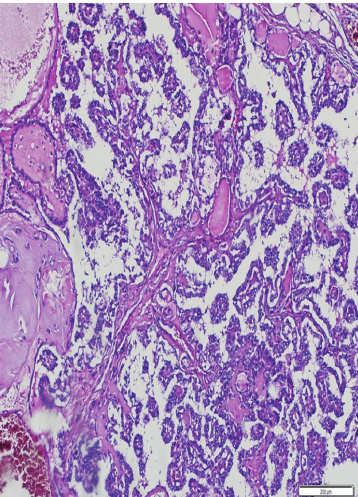
Figure 3: Metastatic focus of papillary carcinoma. It forms cystic papillary structures that are advancing from subcapsular region to the center of the cystic lymph node (H&E × 100).